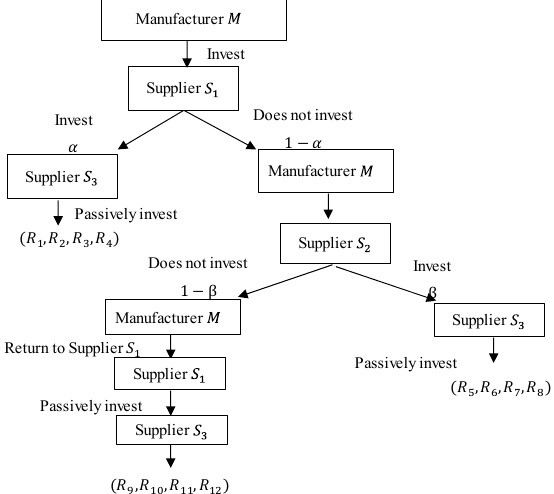
Figure 2. The manufacturer-led one-to-three green supply chain (GSC) game model.